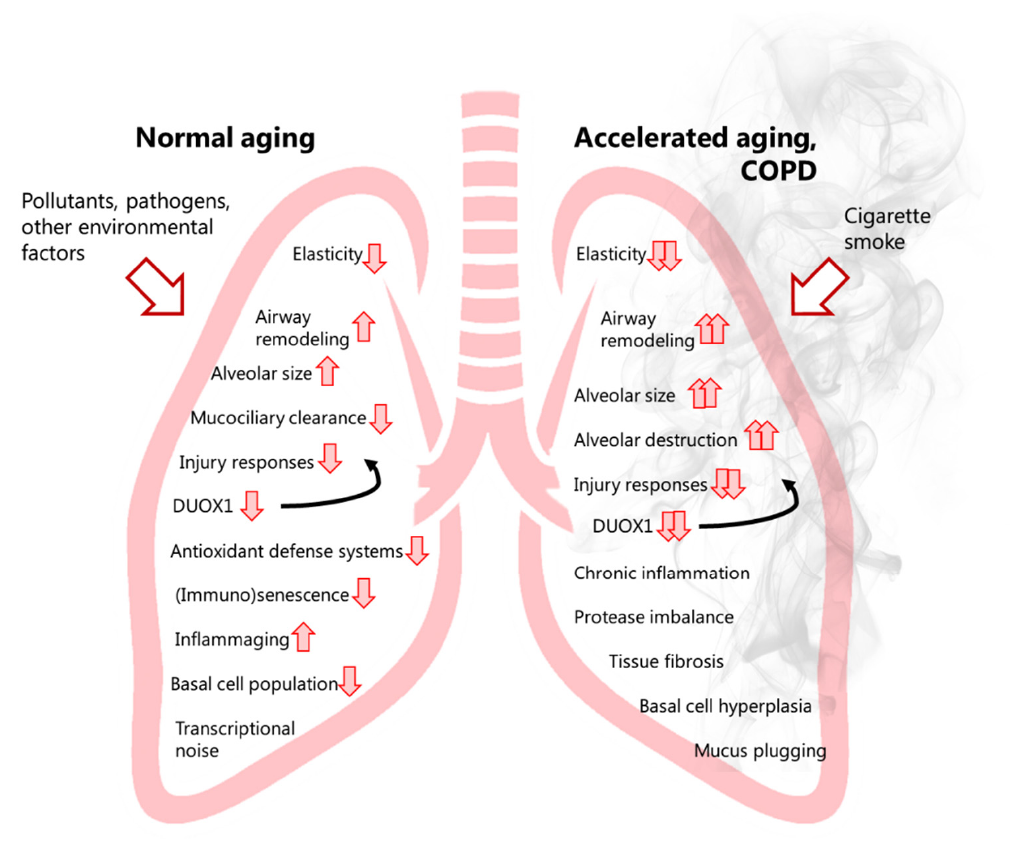
Figure 1. Normal lung ageing versus accelerated lung aging in COPD, with a role for the NADPH oxidase dual oxidase 1 (DUOX1). Various recognized events of normal lung aging (left lung) are described, with additional events occurring only during accelerated lung ageing such as COPD (right lung). The recognized impact of ageing and COPD on DUOX1 and its influence on airway remodeling, lung elasticity, alveolar enlargement, mucociliary clearance and regenerative responses are illustrated therein.